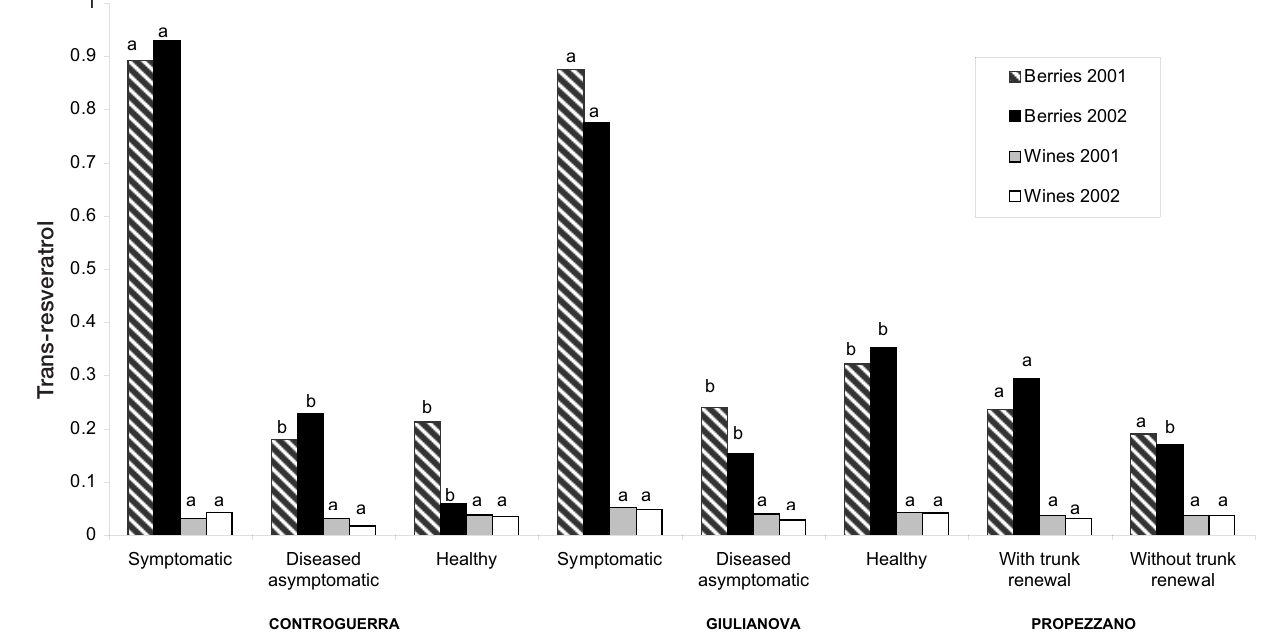
Fig. 1. Trans-resveratrol content of berries (µg g -1 ) and wines (µg ml -1 ) obtained from different groups of vines located in three vineyards (cv. Trebbiano d’Abruzzo) in the Province of Teramo (Italy). The statistical analysis sepa- rately compared berries and wines from each grapevine group in every vineyard and year. Values followed by the same letter do not differ statistically according to Tukey’s test ( P =0.05); each value is the mean of 6 replicates of the grape data and 6 replicates of the wine